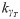
Homeostasis by activity-dependent transporter downregulation.The steady-state internal nutrient concentration for a range of external nutrient concentrations is plotted for six different instantiation of the system in Eq (3): no transporter regulation (black), flux-based transporter downregulation (red with x's), internal nutrient based repression of transporter synthesis (orange), linear external nutrient based transporter downregulation (blue), flux-based transporter downregulation plus internal nutrient based repression of transporter synthesis (green). This illustrates the criterion from Eq (4), which states that the system can only achieve global perfect homeostasis (red and green lines) when flux-based transporter downregulation (kγT) is combined with an arbitrary function of the internal nutrient concentration (Sint).